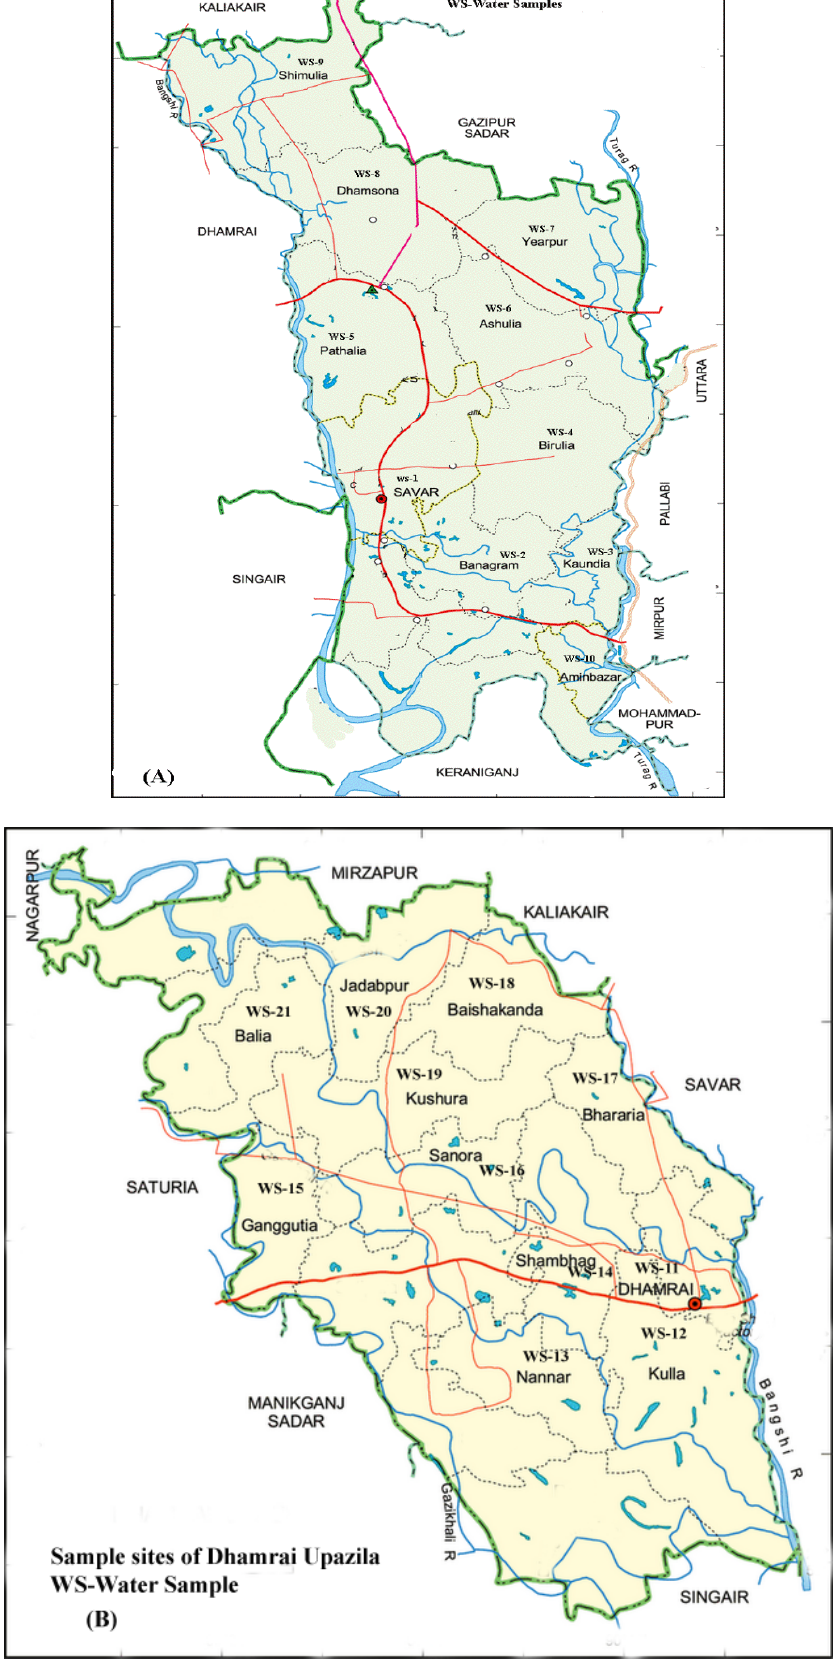
Figure 1. Sample sites of Savar ( A ) and Dhamrai Upazila ( B